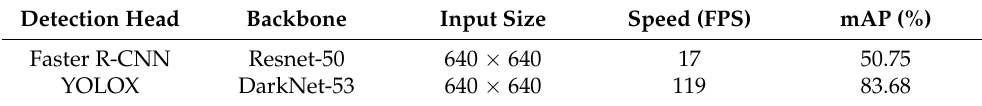
Table 6. Results of UAV